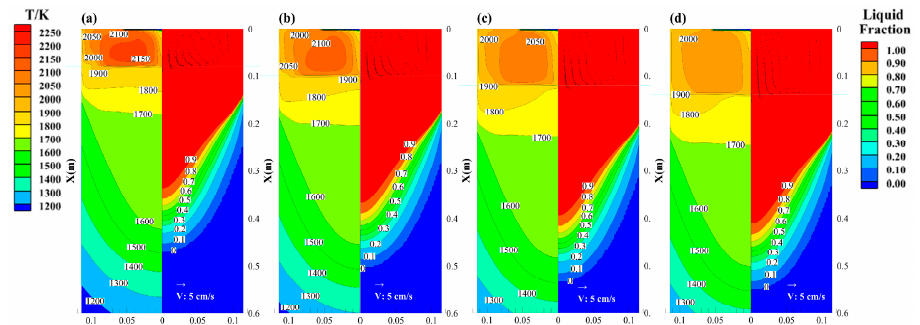
Figure A2. Temperature distribution (left of each figure) and liquid metal volume fraction distribution (right of each figure) as varying slag thickness at end of steady-state: ( a ) 0.08 m, ( b ) 0.10 m, ( c ) 0.12 m and ( d ) 0.14 m.